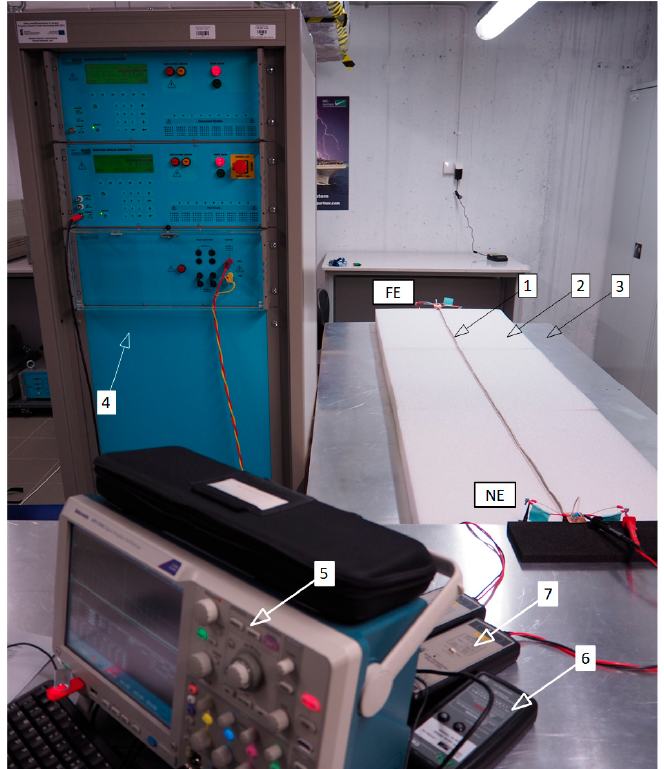
Figure 6. The experimental setup for testing of indirect lightning effects: FE—far-end side, NE—near-end side, 1—cable bundle, 2—dielectric pad, 3—ground plane, 4—MS generator, 5—oscilloscope, 6—current probe, 7—voltage probe.